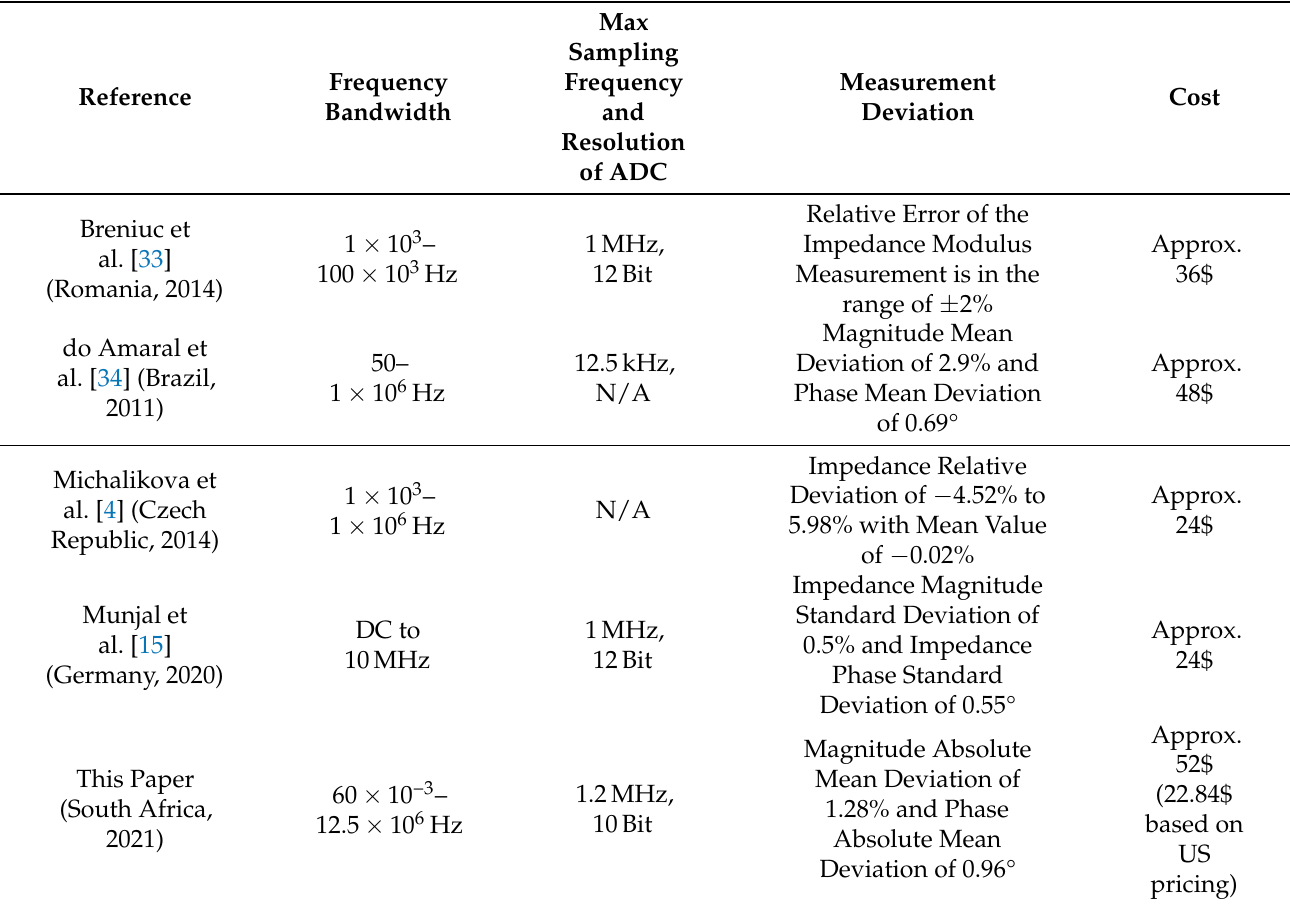
Table 5. Comparison between this work and selected impedance measurement